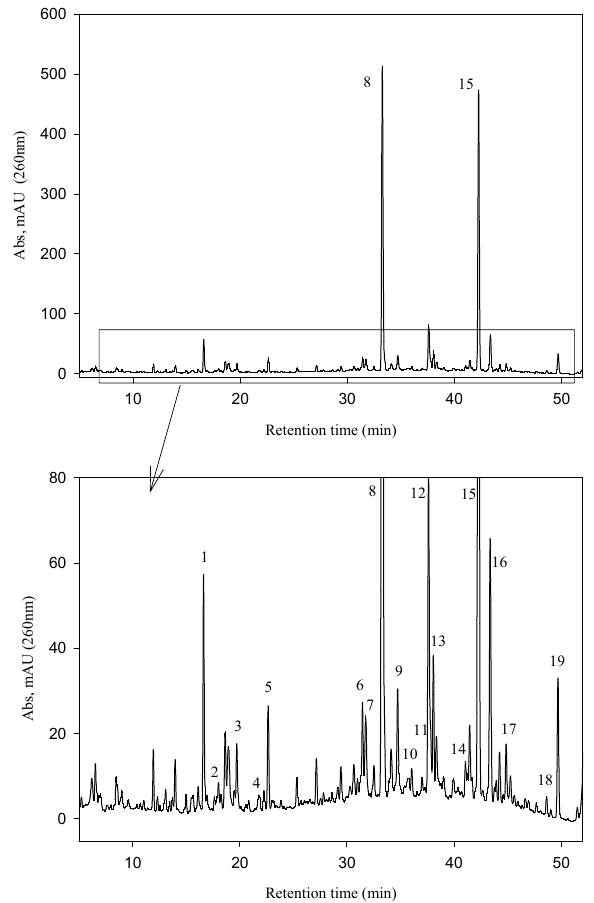
Figure 2. HPLC-UV (260 nm) chromatogram of the Fraxinus angustifolia Vahl seed/fruit extract used in the study. Table 1. Compounds identified in the Fraxinus angustifolia extract used in this study.